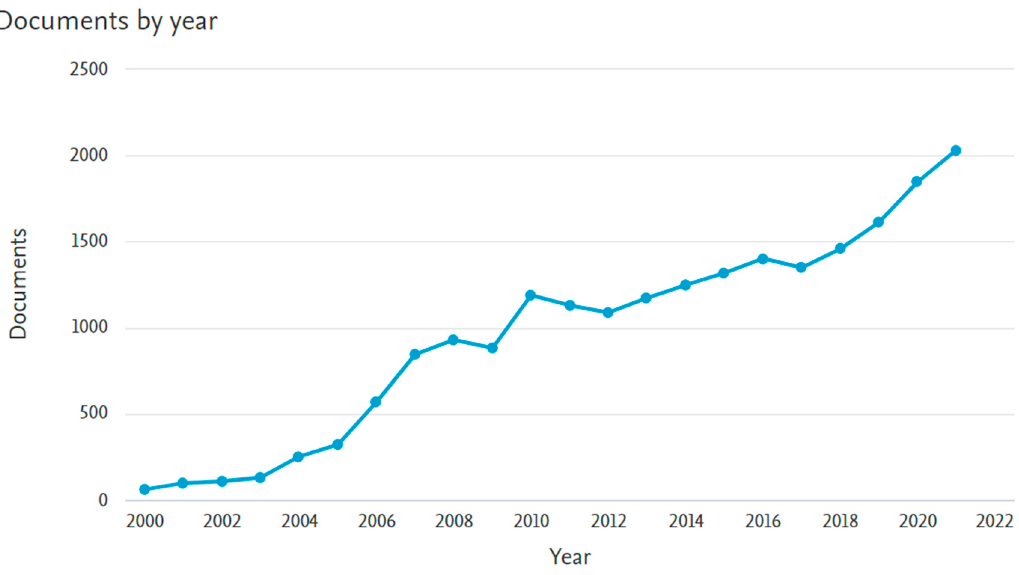
Figure 14. Annual publication output from 2000 to 2021.